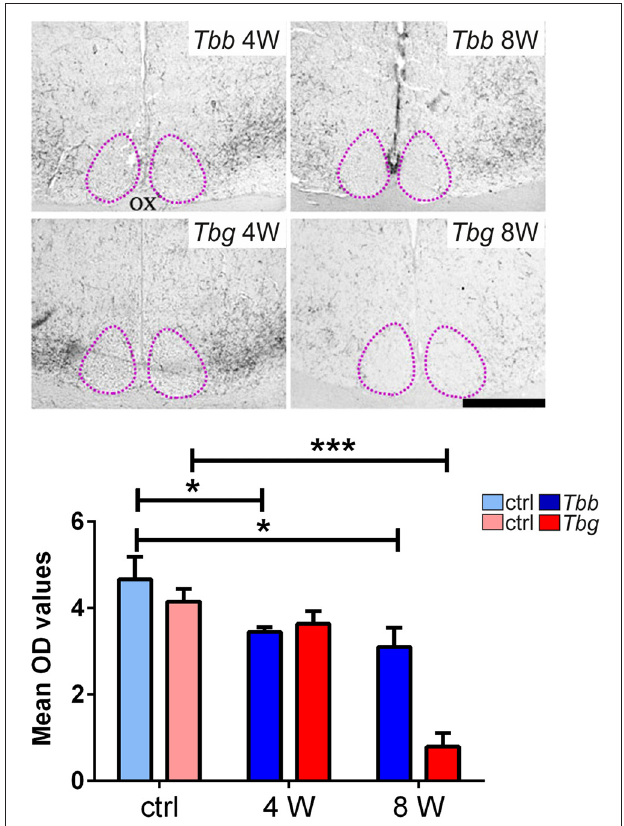
FIGURE 6 | Top: images of the ventral part of the anterior hypothalamus showing OX-A immunoreactive fibers in the region lateral to the suprachiasmatic nucleus (SCN, delimited by a dotted line), in Mastomys natalensis at 4 weeks (W) and 8 W after infection with Trypanosoma brucei brucei ( Tbb ) or Trypanosoma brucei gambiense ( Tbg ). Note that the decrease in the immunoreactive fiber density, especially at 8 weeks after T. b. gambiense infection. Scale bar: 250 µ m. Bottom: bar graphs of the quantitative densitometric evaluation of OX-A immunosignal in the peri-SCN region in control (ctrl) and infected animals. ∗ P < 0.05; ∗∗∗ P < 0.001. Abbreviations: OD, optical density; OX, optic chiasm.